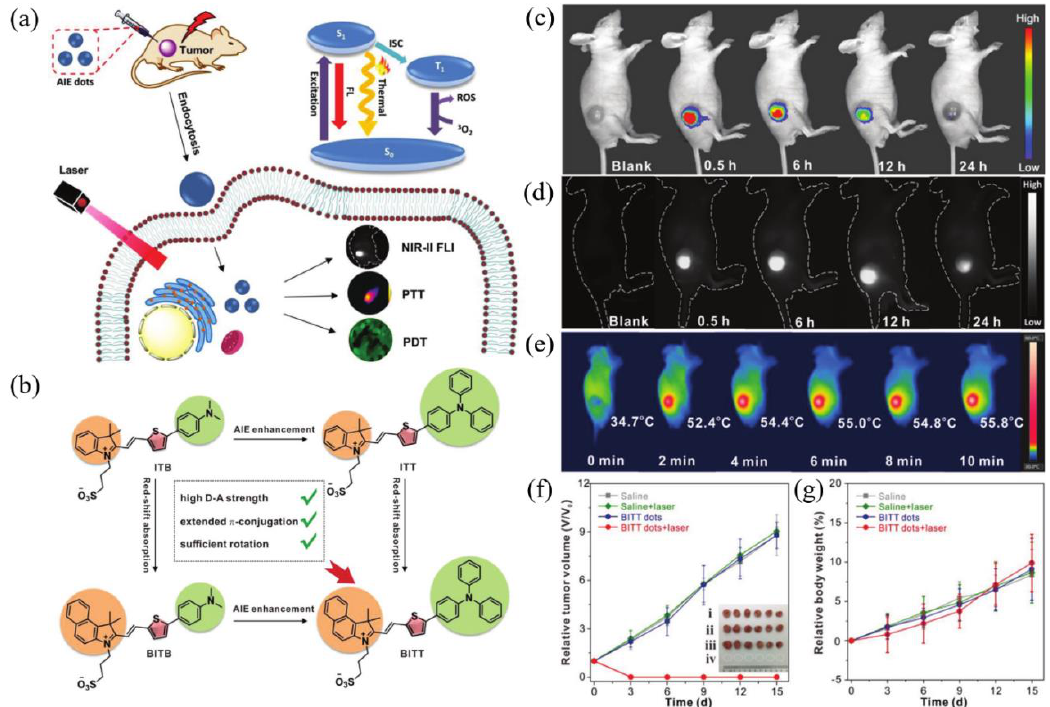
Figure 5. ( a ) Diagram of NIR-II FLI-guided PDT–PTT synergistic therapy for tumor-bearing mice with BITT NPs; ( b ) principle for designing BITT; ( c ) NIR-I FLI and ( d ) NIR-II FLI of tumor-bearing mice after administration of BITT NPs at different monitoring times; ( e ) IR imaging of tumor-bearing mice under laser irradiation at 12 h postinjection of BITT NPs; ( f ) growth curves of tumors with various treatments. Inset: photograph of tumors harvested from the mice at day 15 after different treatment; ( g ) body weight curves of tumor-bearing mice after different treatments at day 15. Reprinted with permission from Ref. [75]. Copyright 2021, Wiley-VCH.